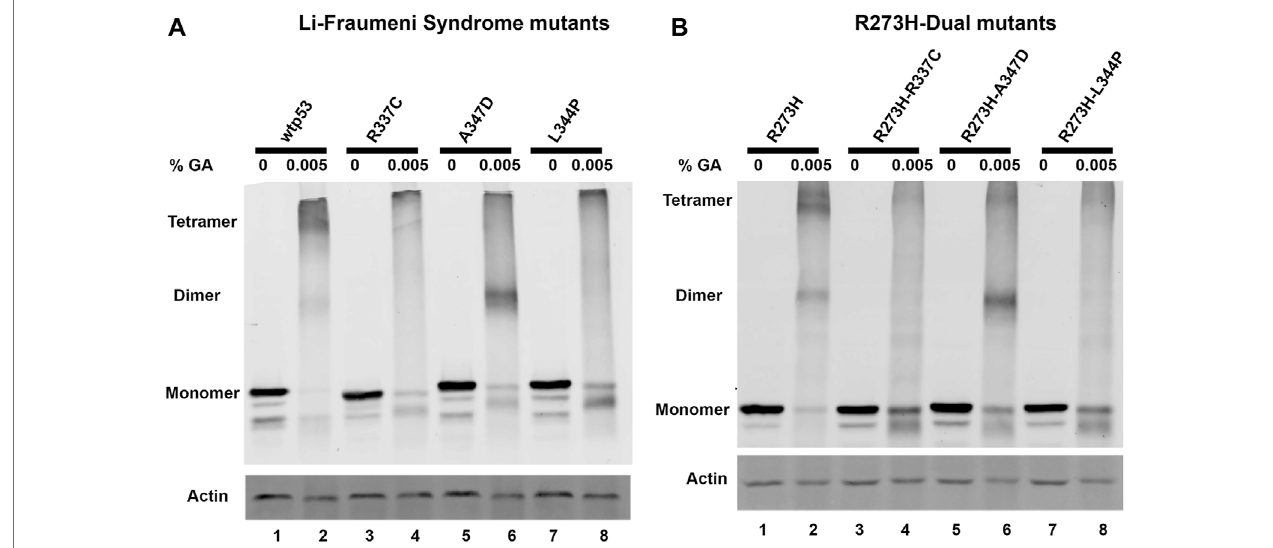
FIGURE1 | R273H-dual mtp53 mutants destabilize oligomerization ofmtp53 R273H similartoLi-Fraumeni Syndrome single mutants. HCT116 p53 − / − cells were transiently transfected with plasmids expressing either (A) wtp53, or single mutants R337C, A347D or L344P; or (B) mtp53 R273H, or dual mutants R273H-R337C, R273H-A347D, or R273H-L344P. After 24 h post transfection, cells were pelleted, and lysate prepared. 50 μ g of the resulting cell lysates were treated with either 0% (lanes 1,3,5,7) or 0.005% (lanes 2,4,6,8) glutaraldehyde for 20 min at room temperature. Samples were run on an 8% SDS-PAGE and oligomerization determined by western blotting using anti-p53 DO1 antibody. Actin was used as a normalizer and showed very minor shift in mobility with 0.005% glutaraldehyde. Data presented was reproduced in three biological replicates.